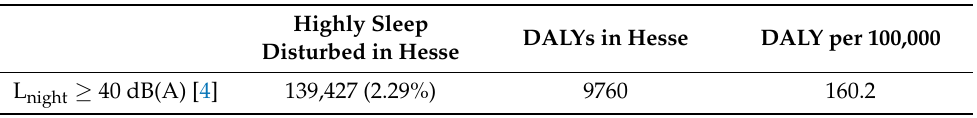
Table 6. Estimated number of residents highly annoyed due to road-traffic noise and respective DALYs in Hesse (all ages). Highly Sleep DALYs in Disturbed in Hesse